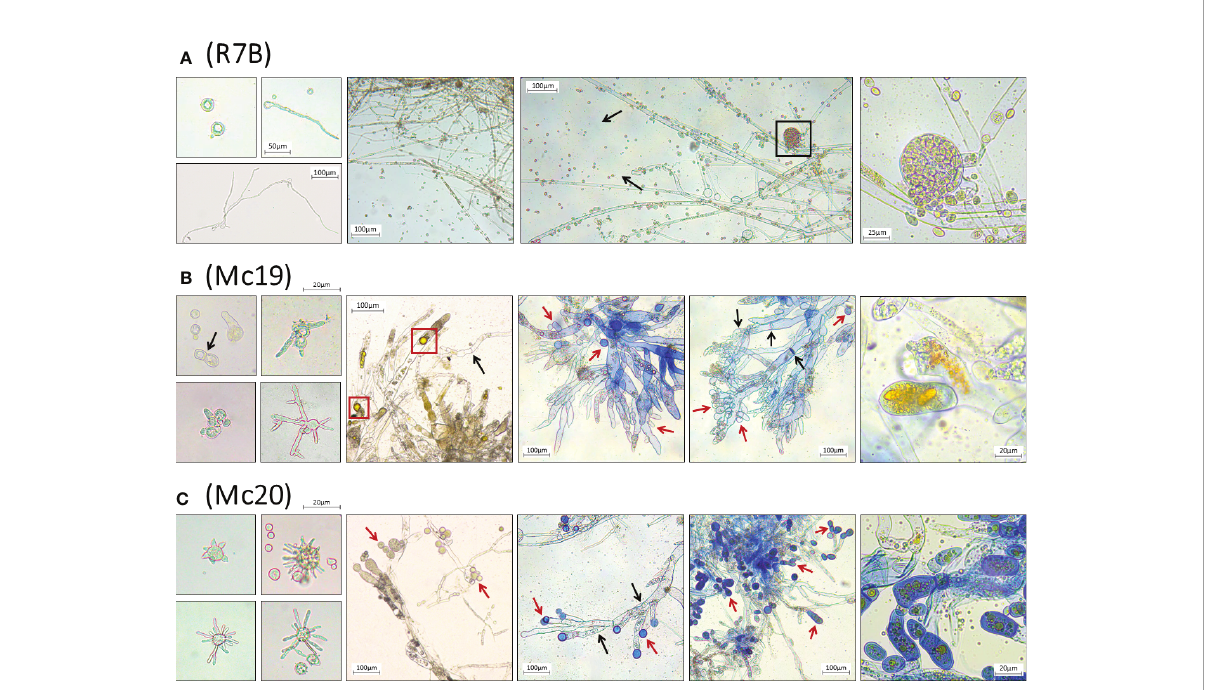
FIGURE 6 Microscopic images of morphological abnormalities of vegetative spores during germination, yeast-like cells, and fungal hyphae of the myosin II null mutant D mcmyo2A (B) and D mcmyo2B (C) , compared to the hyphae and the sporangia containing vegetative spores of the wild-type R7B (A) . The disruption of myosin II encoding genes led to a declination of sporulation. The mutants generate yeast-like cells, which locate in the hyphal tips and are separated from the hyphae by pseudo septa. The yeast-like cells and fungal hyphae of the mutants contain numerous pigment- fi lled vesicles. The black box denotes the sporangium containing vegetative spores; red boxes denote the pigment- fi lled vesicles in fungal cytoplasm. Black arrows point to the septa in fungal hyphae; red arrows point to the yeast-like cells of the mutants. The fresh vegetative spores were cultured in MMC liquid media (pH 3.2), while separated colonies of different strains grown on MMC solid media (pH 3.2) provided the mycelia to make specimens for microscopic